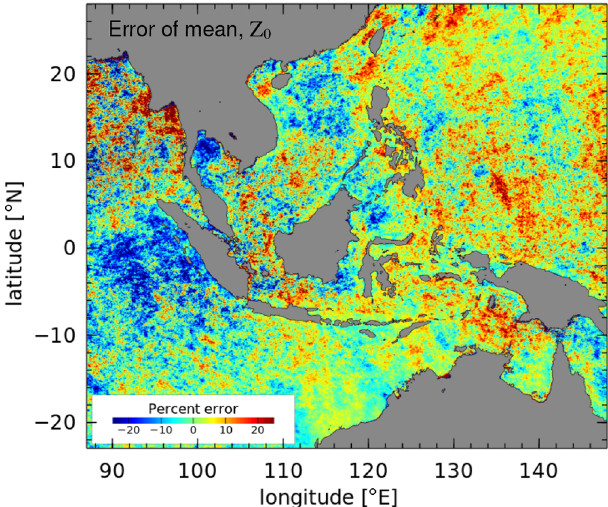
Figure A2. The relative error in the estimated mean ( Z 0 ) of the meridional wind shows the effect of Chl a data gaps at each pixel. For this example, the time series of the NCEP reanalysis 850mbar meridional wind at 7.5 ◦ S, 110 ◦ E is taken as the reference gap-free “truth”, and the mean is compared with the mean estimated from the gappy time series at each oceanic pixel, according to the Chl a data indicator. The error is a measure of the crosstalk of non-sinusoidal (broadband) variability near the S a frequency which is aliased back to the mean by the gappy sampling. This map shows where data gaps caused by cloudiness are likely to bias the mean estimated for Chl a